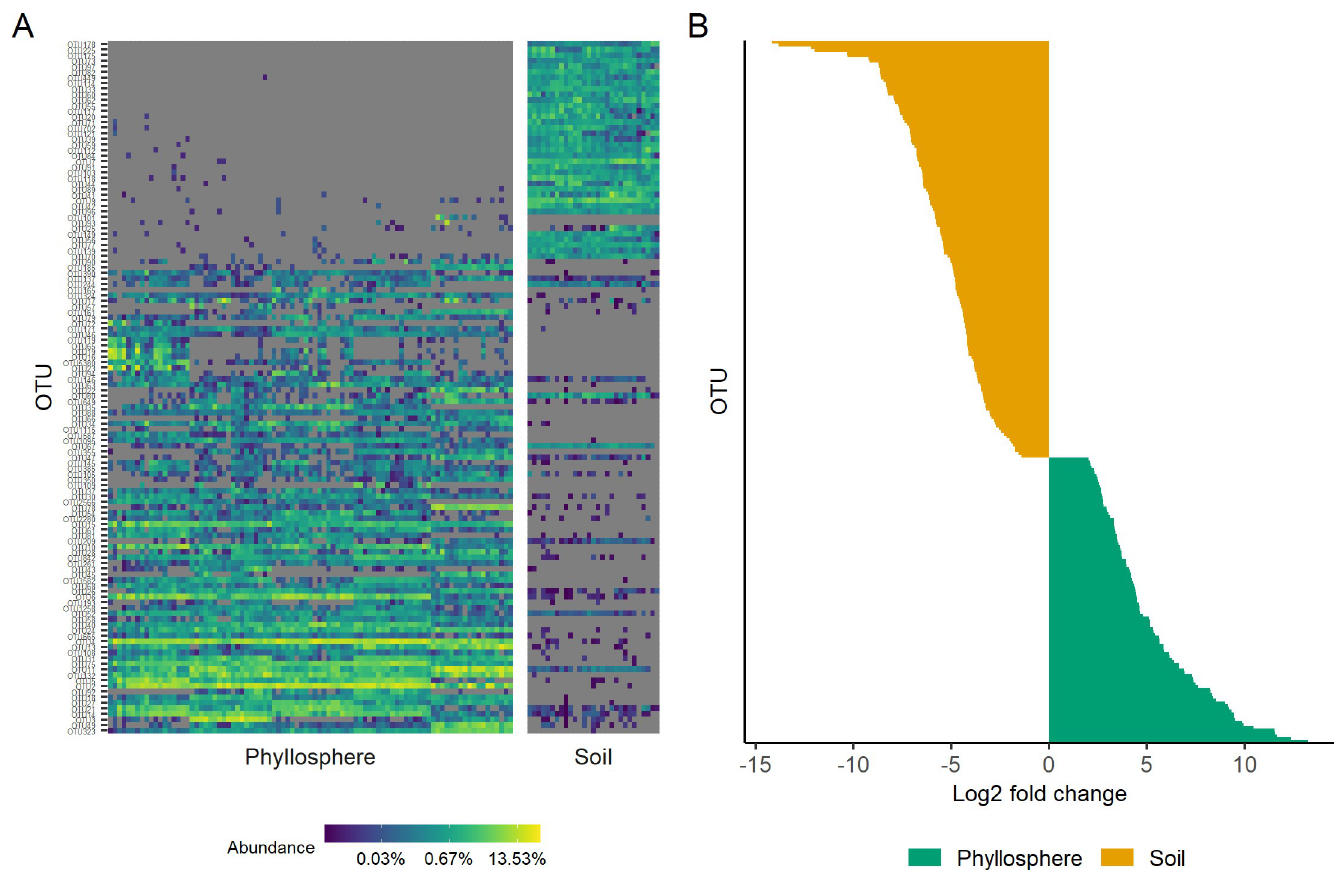
Fig 2. Differential abundance of taxa in phyllosphere and associated soil communities. (A) Heatmap depicts the differential relative abundance of OTUs in each environment. Only OTUs with mean relative abundance greater than 1 x 10 − 3 are included. (B) OTUs present in both phyllosphere and soil communities that exhibit significant differential abundances. Positive log2 fold change values represent OTUs with increased abundance in the phyllosphere relative to soil (n = 104) and those with negative log2 fold change values represent OTUs with increased abundance in soil relative to the phyllosphere (n = 152). A full list of OTUs with significant differential abundances, defined by DeSeq2 log-fold difference with an adjusted p value of � 0.01, is presented in S8